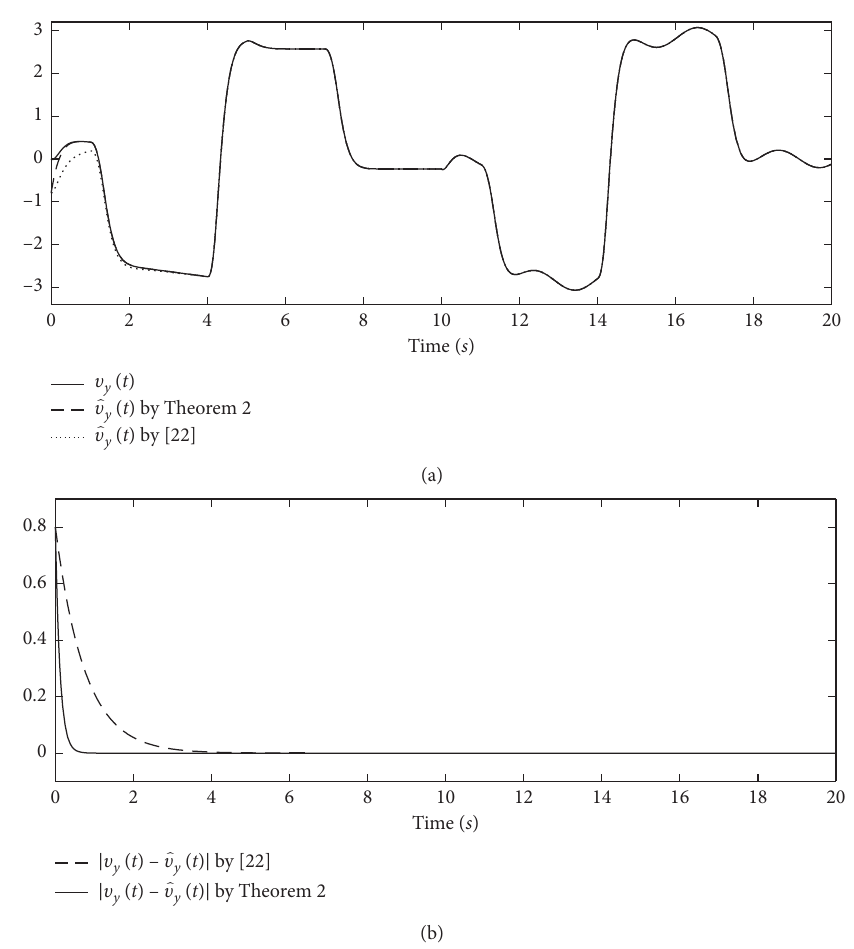
Figure 4: (a) Time evolution of lateral velocity and its estimates. (b) Error estimation of lateral